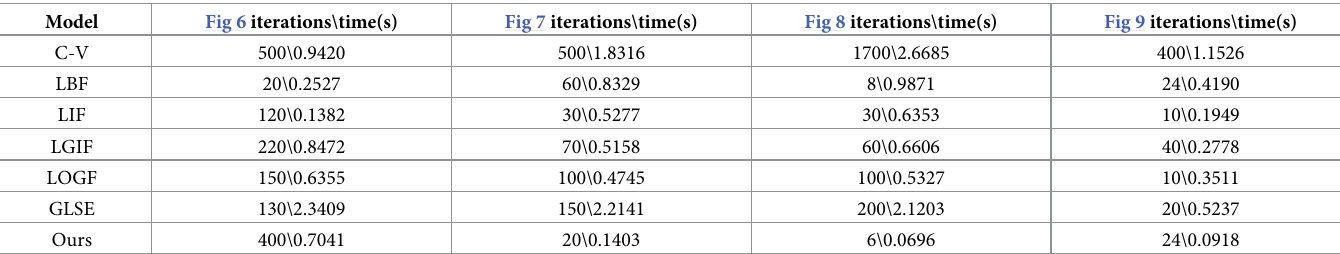
Table 2. Iterations \ execution time(s) of Figs 6–9. Model Fig 6 iterations\time(s) Fig 7 iterations\time(s) Fig 8 iterations\time(s) Fig 9